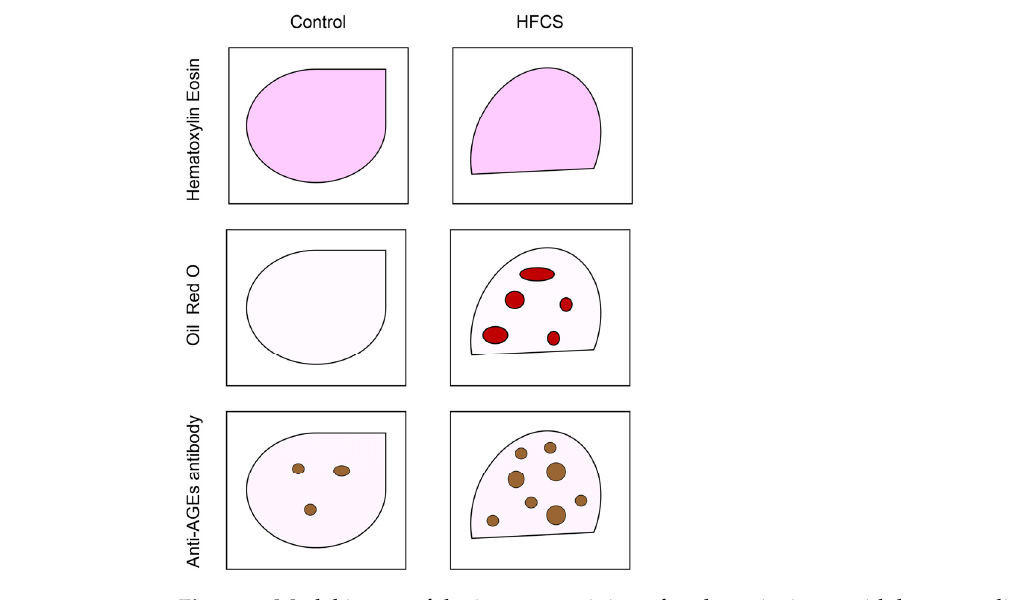
Figure 5. Model image of the immunostaining of rat hepatic tissue with hematoxylin and eosin, oil red O, and anti-AGE antibody. Control: hepatic tissues of rats that had drunk water. HFCS: hepatic tissues of rats that had drunk high-fructose corn syrup (HFCS). Closed red circles are steatosis drops. Closed brown circles are the areas where anti-AGE antibody was probed.